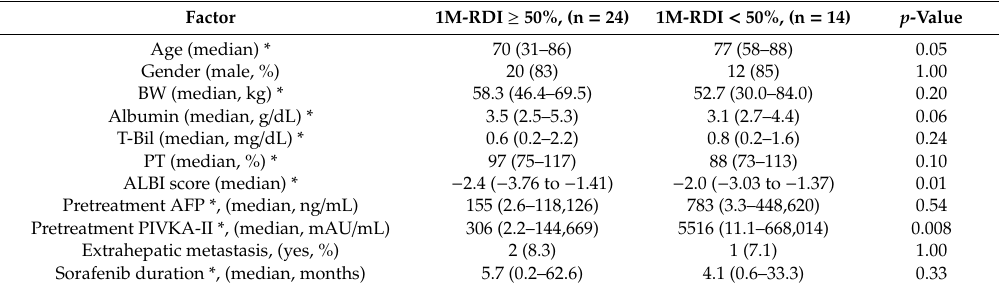
Table 3. Comparison of baseline characteristics between patients with 1M-RDI ≥ 50% and 1M-RDI < 50%.